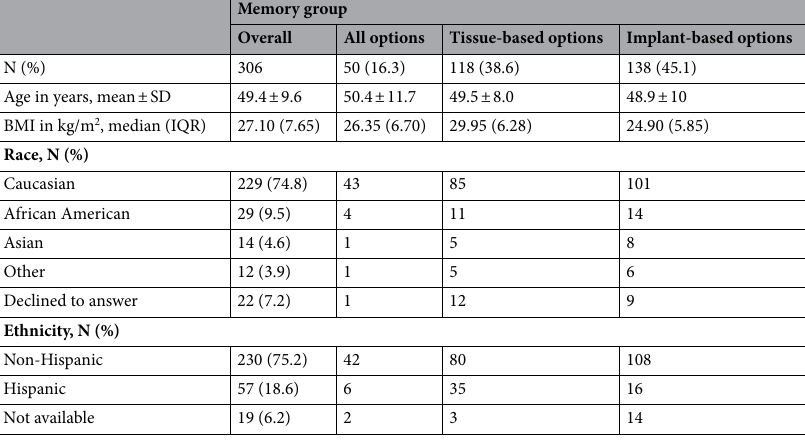
Table 1. Patient